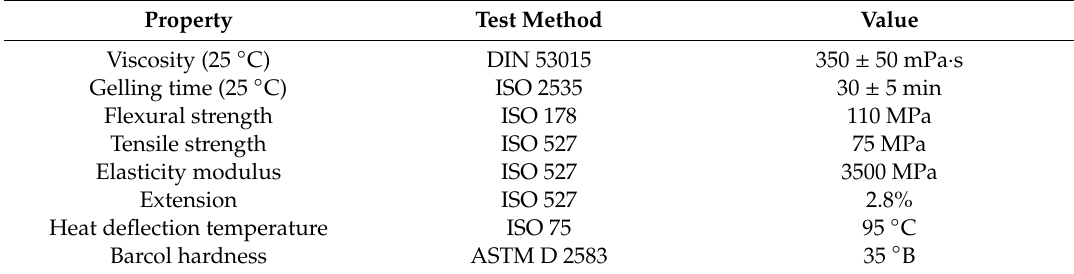
Table 1. The properties of vinyl ester resin used as the binder of tested mixes (www.ciechresins.com).